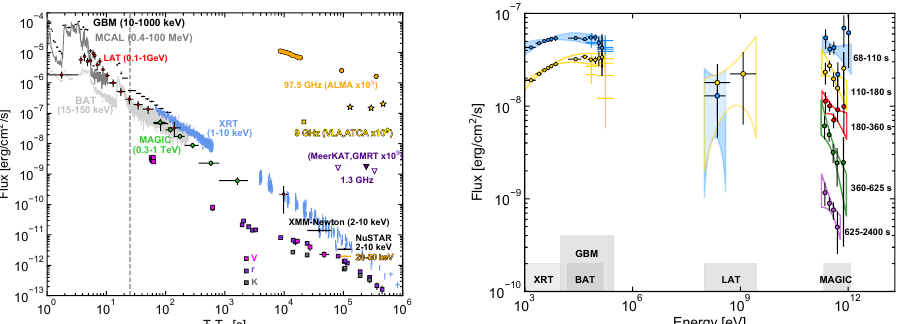
Figure 5. Observations of GRB 190114C, detected at VHE by the MAGIC telescopes. Left : lightcurves at different wavelengths, from radio to γ -rays, versus time since the BAT trigger time. The MAGIC light curve (in the energy range 0.3–1TeV, green circles) is compared with light curves at lower frequencies. The vertical dashed line marks approximately the end of the prompt emission phase, identified with the end of the last flaring episode. For the data points, vertical bars show the 1 σ errors on the flux. Right : multi-band spectra in the time interval 68–2400 s. Five time intervals were considered: 68–110 s (blue), 110–180 s (yellow), 180–360 s (red), 360–625s (green), and 625–2400s (purple). MAGIC data points have been corrected for attenuation caused by the EBL. Data from other instruments are shown when available (i.e., for the first two time-intervals): XRT, BAT, GBM, and LAT. For each time interval, the LAT contour regions are shown limiting the energy range to the range where photons are detected. MAGIC and LAT contour regions were drawn from the 1 σ error of their best-fit power law functions. For Swift data, the regions show the 90% confidence contours for the joint fit XRT-BAT obtained, fitting to the data a smoothly broken power law. Filled regions were used for the first time interval (68–110 s, blue color). Both figures are from